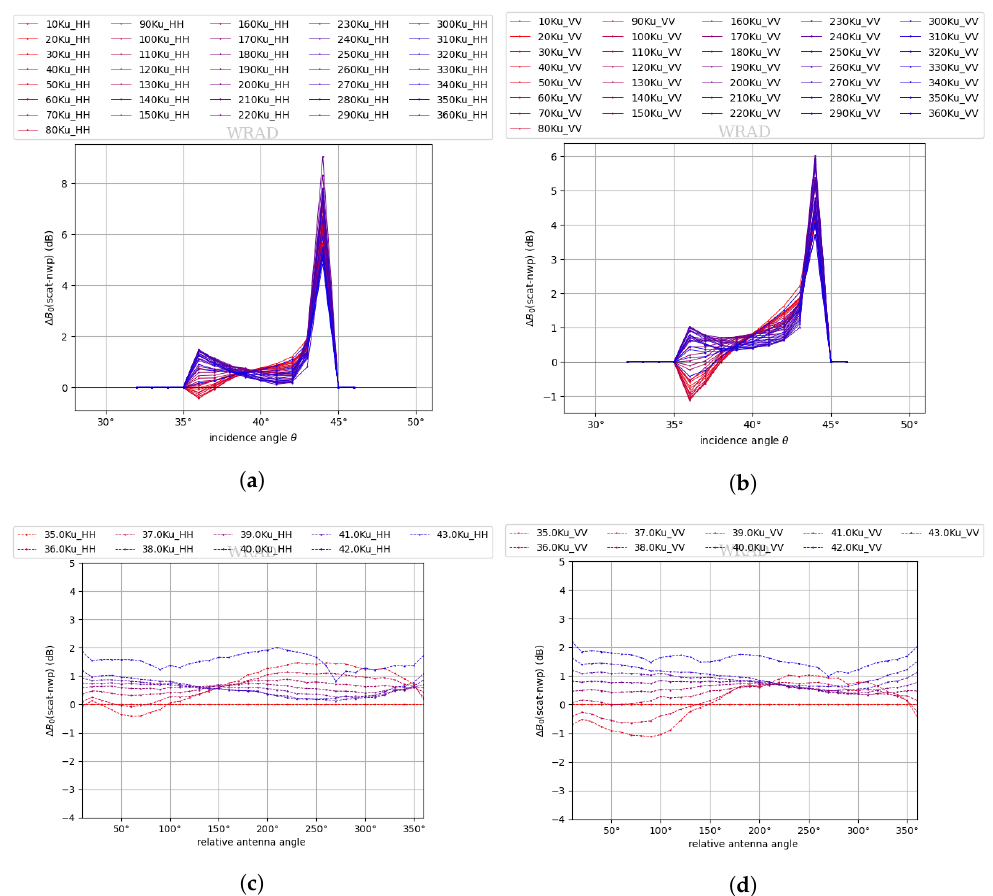
Figure 9. Ku-band NOCant (NOC as a function of incidence angle and relative antenna angle) for ascending orbits. The upper panel is as a function of incidence angle ( x -axis) per relative antenna angle (red to blue lines), the lower panel is as a function of relative antenna angle ( x -axis) per incidence angle (red to blue lines): ( a , c ) HH polarization; ( b , d ) VV